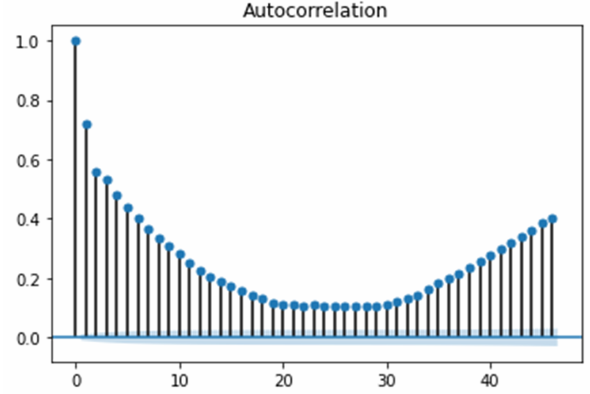
Figure 6. The first differencing applied to